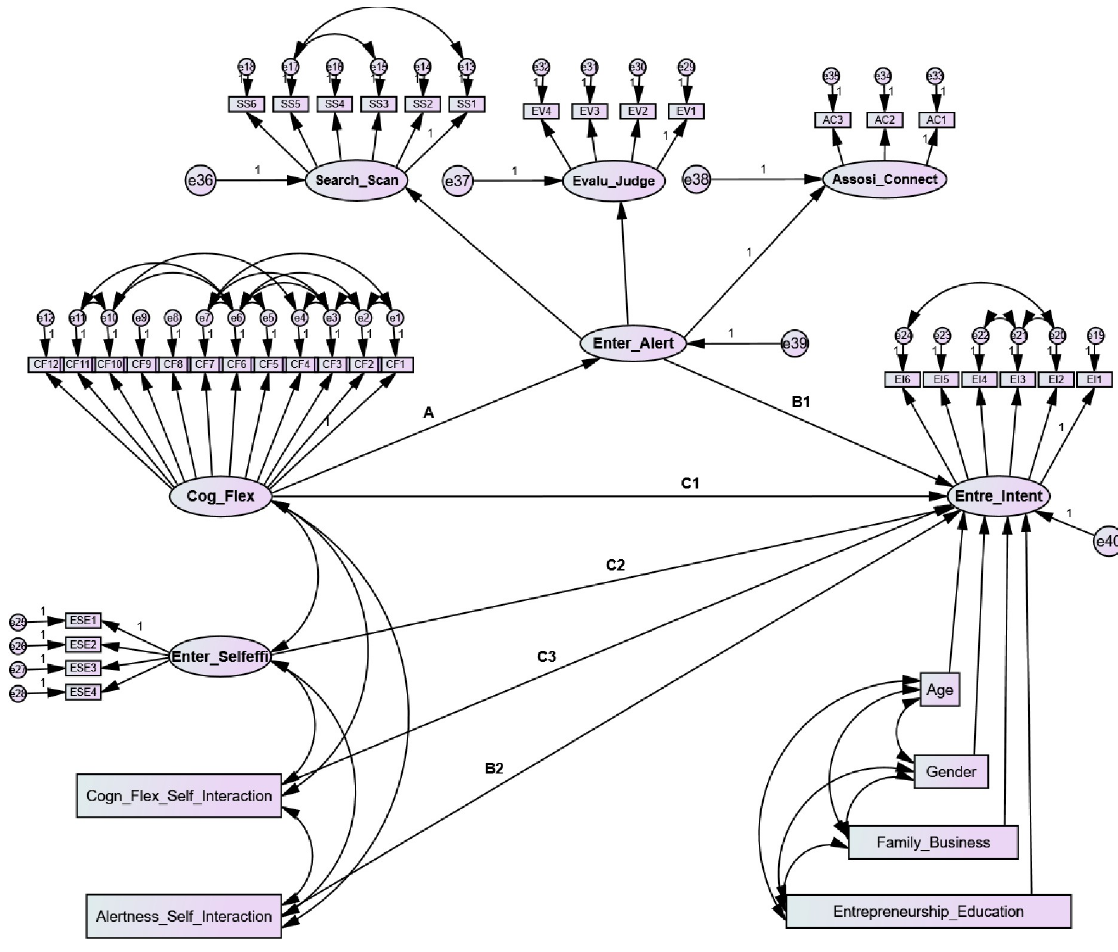
Fig 3. Under-defined path